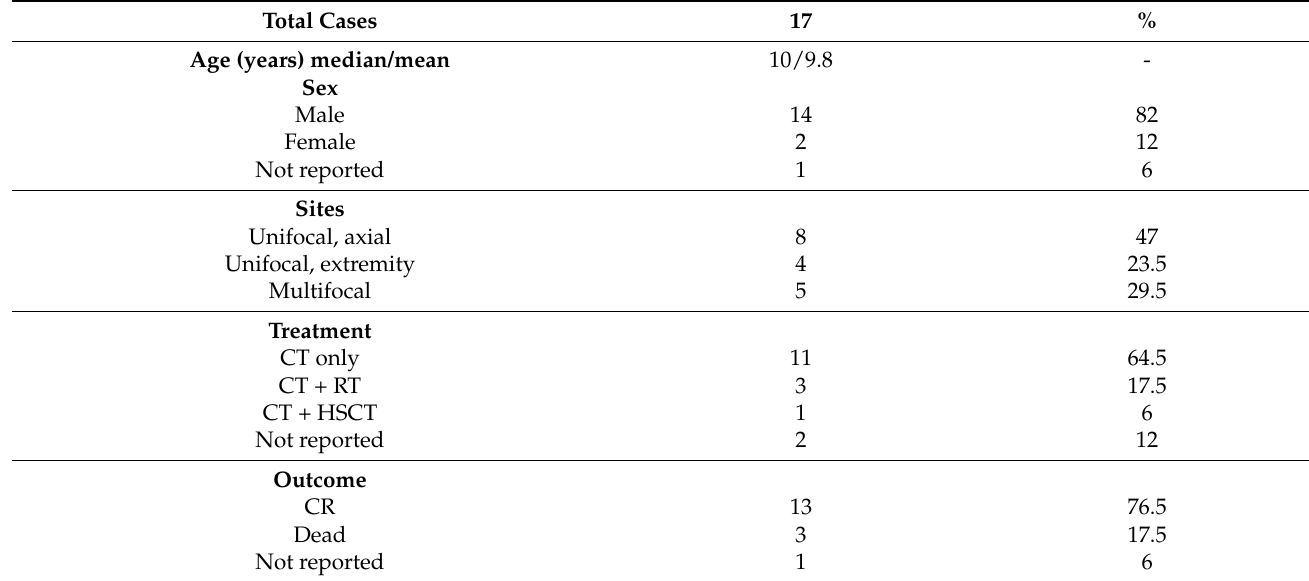
Table 3. Main features of pediatric primary bone ALCL.